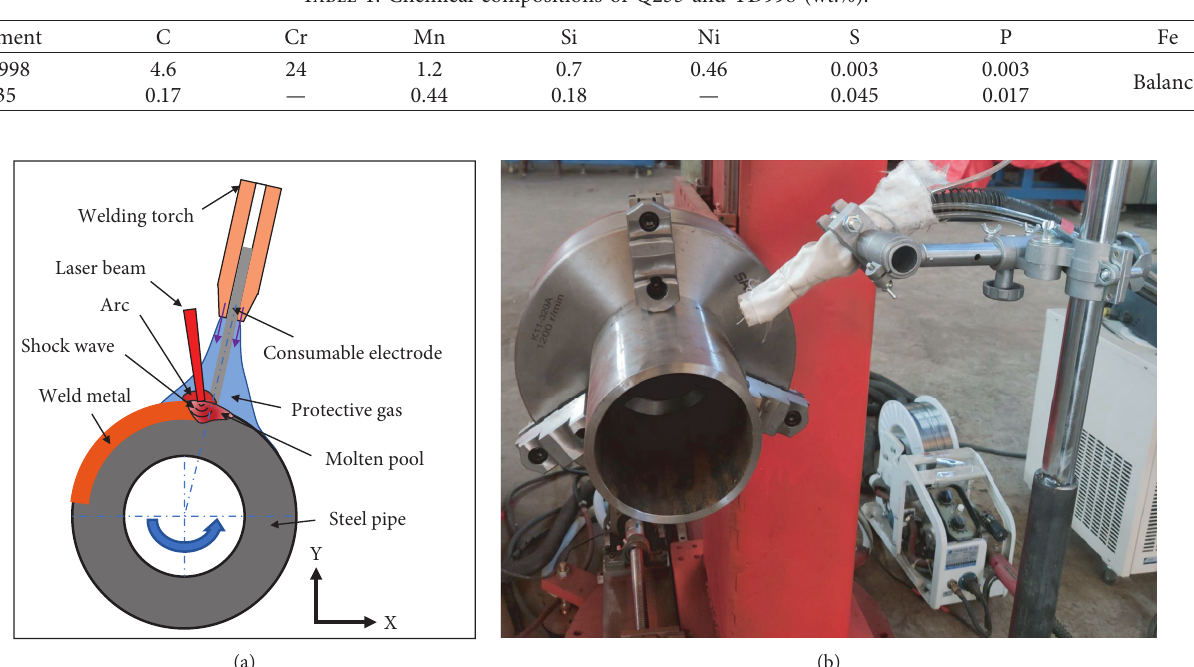
Table 1: Chemical compositions of Q235 and YD998 (wt.%).